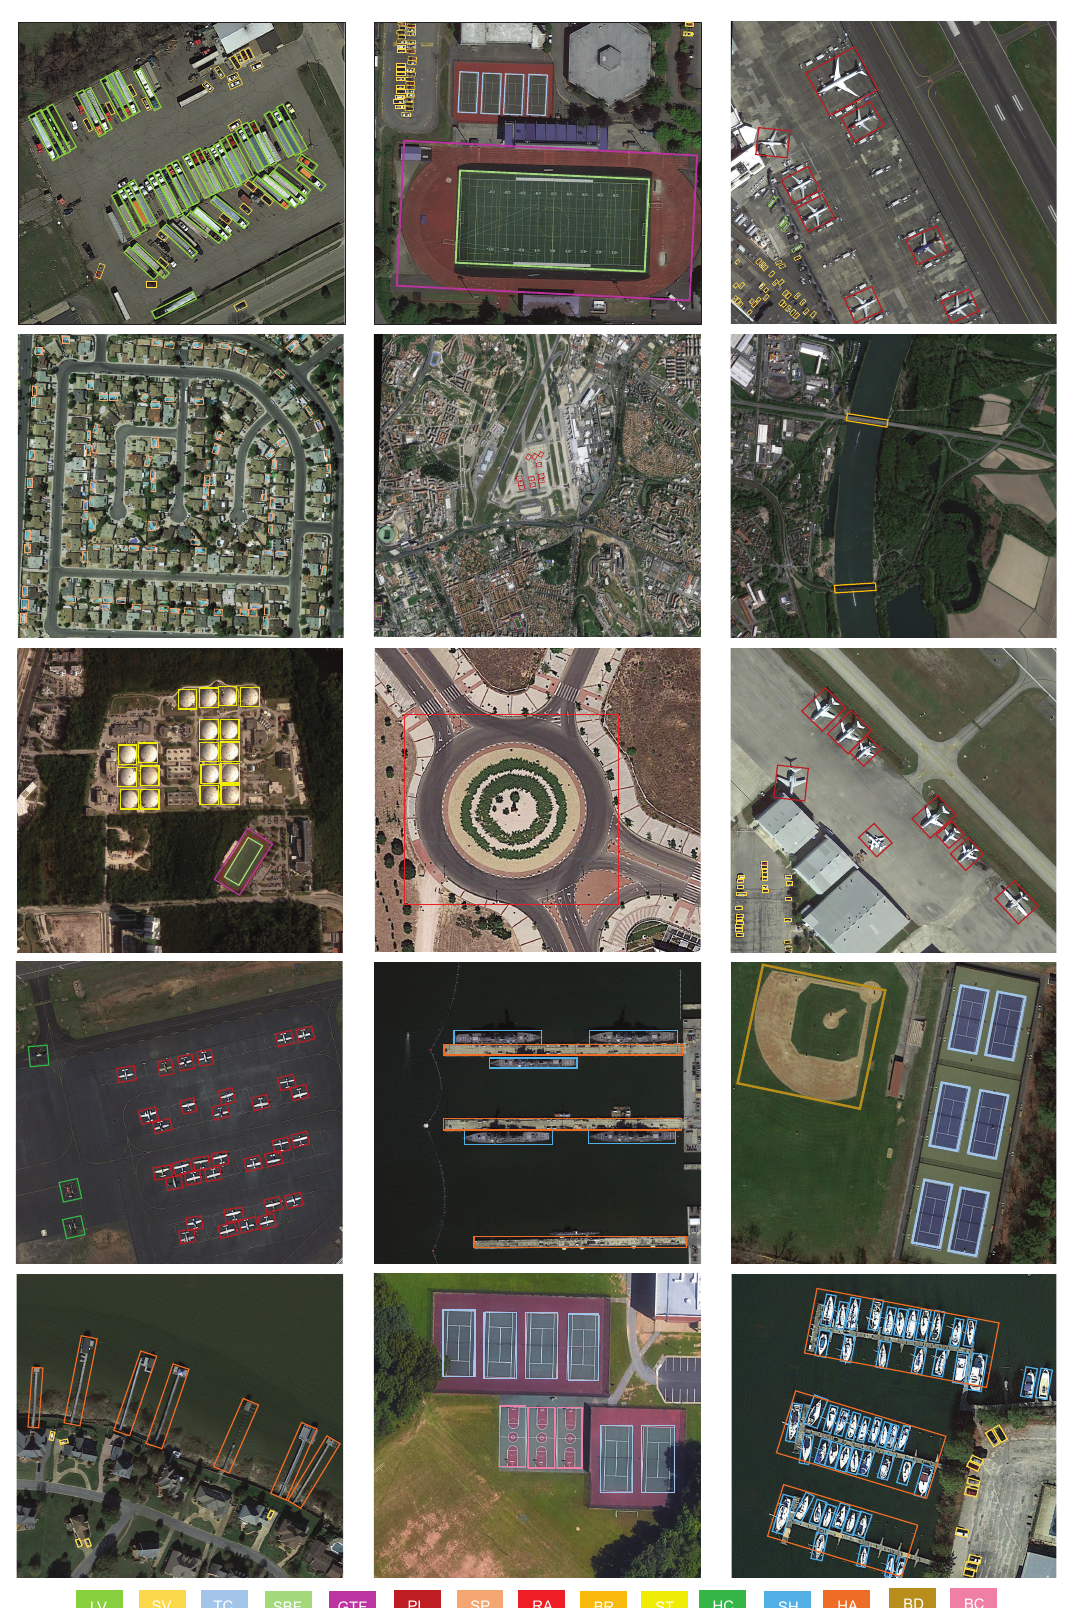
Figure 7. Visualization of the detection results of our method on the DOTA